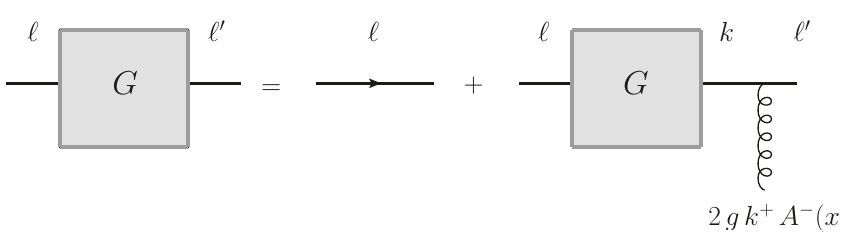
Figure 1 . Diagrammatic illustration of the scalar propagator in a background